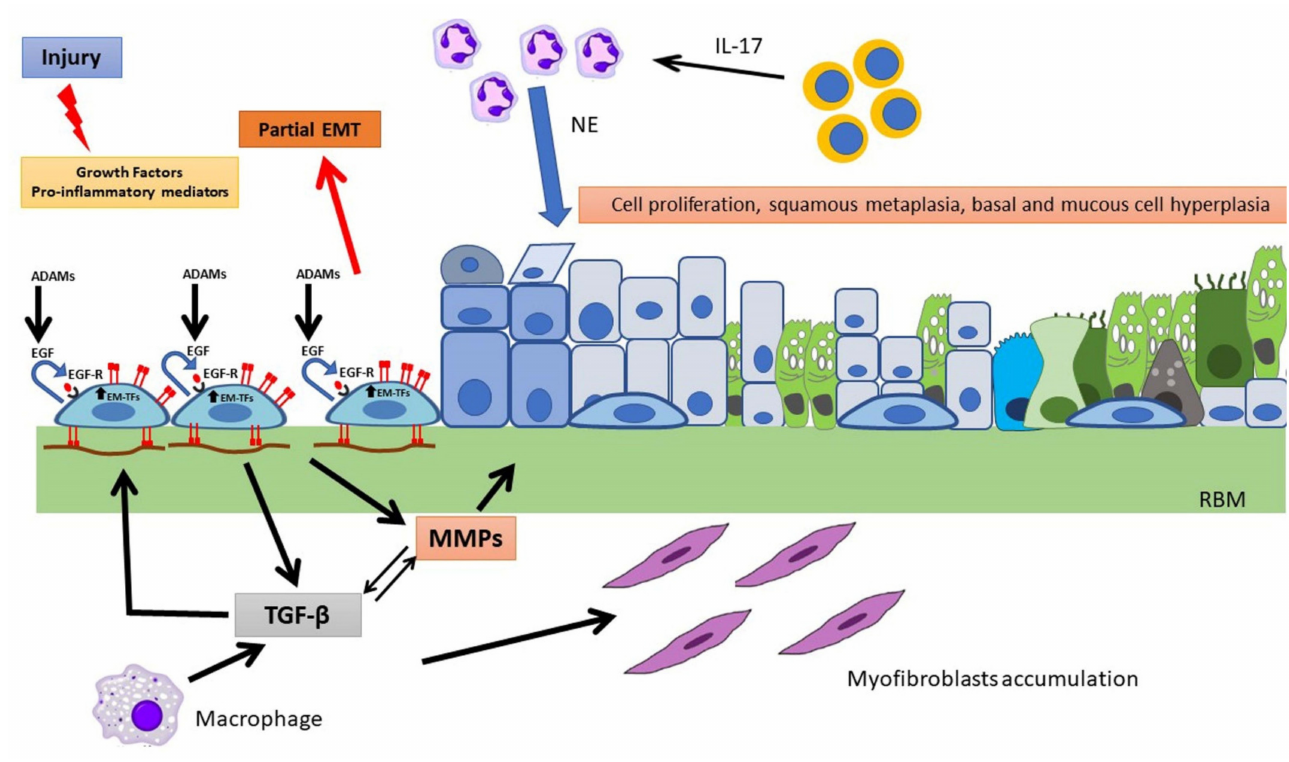
Figure 5. Wound repair and regeneration in a CF airway epithelium. The pro-inflammatory milieu of the CF airways and the partial EMT state of CF airway epithelial cells (as represented by the detachment of a single cell from the epithelial sheet)) stimulate processes involved in regeneration and repair that are exaggerated in regard to a non-CF epithelium (as one can observe by the arrow thickness in comparison to Figure 2). However, the wound repair does not occur properly, eventually leading to persistence of cell proliferation, squamous metaplasia, and basal and mucus cell hyperplasia. The thickening of reticular basement membrane (RBM) is likely due to elevated TGF- β levels and enhanced myofibroblast differentiation and accumulation. Neutrophils infiltrate the CF airways following IL-17 secretion by T cells and produce mediators (e.g., NE) that retard the wound